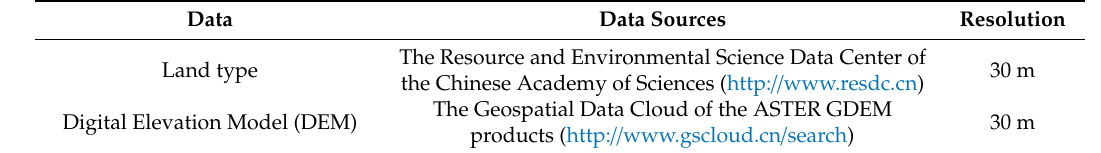
Table 1. Data types and